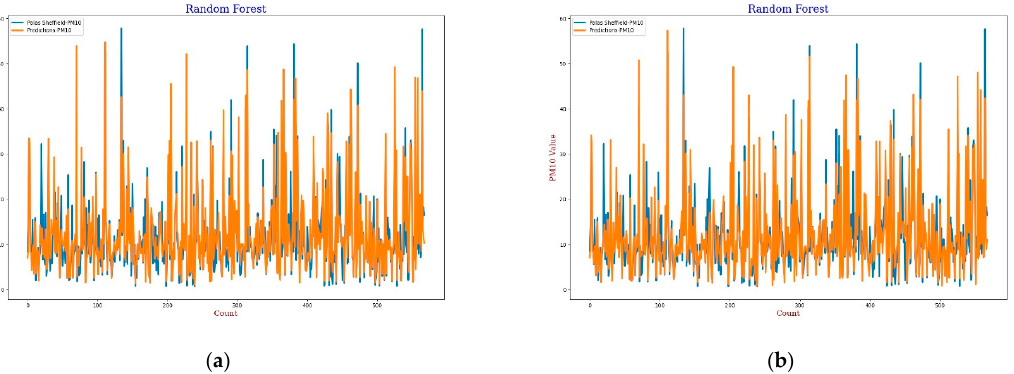
Figure 19. ( a ) RF calibration plot for PM 10 using AH . Blue colour represents the reference data and orange colour represents the calibrated data; ( b ) RF calibration plot for PM 10 using RH . Blue colour represents the reference data and orange colour represents the calibrated data.